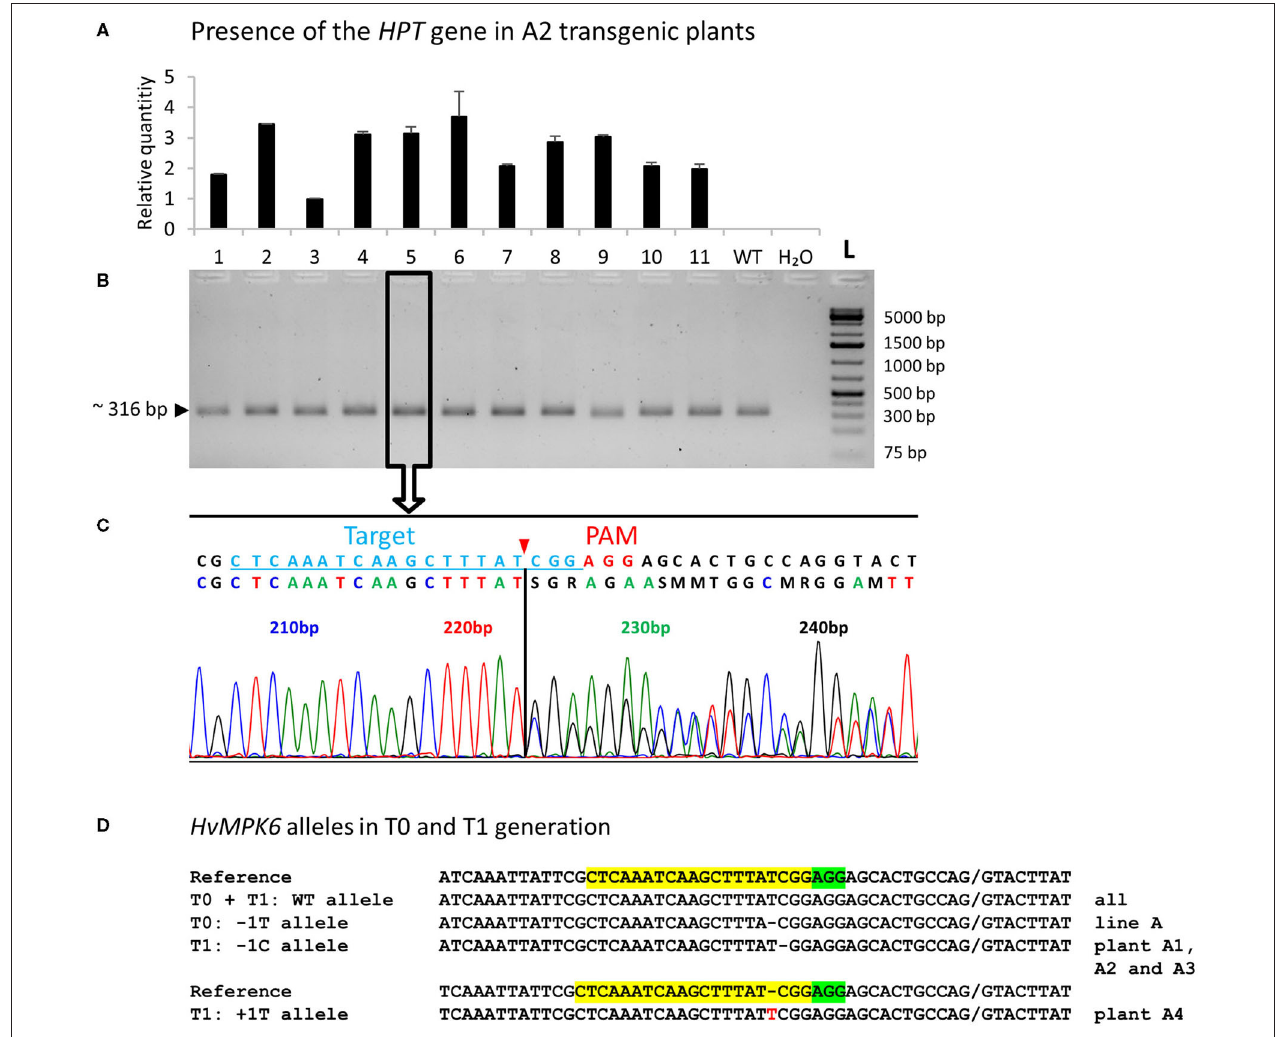
FIGURE 2 | Genotyping of the transgenic barley plants by multiplex TaqMan qPCR and on-target region sequencing—representative results and decoding of the HvMPK6 alleles of T0 and T1 plants. (A) Genotyping of T2-generation plants for the presence of the CC9-K6E3 construct. Genomic DNA was extracted from the leaves of 11 transgenic plants (numbered 1–11) and 1 wild-type (WT) plant and analyzed for the presence of the HPT gene by multiplex TaqMan qPCR with primers/probe sets for the HPT gene and barley reference CO2 gene ( Supplementary Table 1 ). Using the 2 − 11 Ct method ( Livak and Schmittgen, 2001), the amount of the HPT gene was normalized to the amount of the CO2 gene and is shown for each sample as relative to the sample from plant 3. All the analyzed transgenic plants contained a HPT gene whereas WT plant and a negative water-template control (H 2 0) did not. (B) The same plants were genotyped for the gRNA:Cas9-induced on-target mutations by PCR sequencing (PCR-Seq). The DNA fragment covering the on-target region was amplified from the genomic DNA of the analyzed plants by using PCR with primers K6E3_F1/K6E3_R1 ( Supplementary Table 1 ). About 316-bp PCR amplicon was associated with all analyzed plants including WT plant but not with a negative water-template control (H 2 O) L- O’GeneRuler 1kb Plus DNA Ladder (Thermo Fisher Scientific, Waltham, MA, USA). The expected size of the non-mutated PCR product is shown on the left, and the sizes of the selected ladder fragments are shown on the right. All about 316-bp PCR amplicons were sequenced. Open rectangle with an arrow indicates about 316-bp PCR amplicon associated with the plant 5 for which sequencing results are shown below. (C) Two overlapping sequencing chromatograms of similar signal intensity indicate heterozygous (monoallelic) or biallelic mutation in the HvMPK6 gene. Above the chromatograms, a deduced color-coded nucleotide sequence and reference WT nucleotide sequence including the position of the on-target site (underlined light blue typing) and the PAM site (red typing) are shown. The nucleotide numbering is shown as the distance in base pairs (bp) from the first nucleotide of the K6E3_F1 primer site. The deduced sequence corresponds to the WT sequence up to the third nucleotide position upstream of the PAM site (indicated by a vertical solid line) at which peaks start to overlap. Cas9 endonuclease from Streptococcus pyogenes cleaves target DNA sequences most frequently after the third nucleotide upstream of a PAM site (Jinek et al., 2012; Ran et al., 2015) (red arrowhead). The vertical solid line and red arrowhead point to the same position suggesting that the on-target was cleaved at the expected site and that the mutation/mutations occurred next to the cleavage site in the downstream direction relative to the PAM site. (D) HvMPK6 alleles of the mutated T0 and T1 transgenic plants. Superimposed sequencing chromatograms were decoded into allelic sequences by using the DSDecodeM tool (Liu et al., 2015b). The selected region of the WT HvMPK6 allele (plus strand) is shown as a reference on the top of each multiple sequence alignment with the gRNA on-target and PAM site highlighted in yellow and green, respectively. Slash indicates an exon/intron boundary and dash indicates single-nucleotide deletion. An inserted nucleotide is typed in red. The designation of an allele and respective transgenic generation is shown on the left and the designation of the line/plant is shown on the right of each sequence. Minus indicates deletion, plus indicates insertion, and bp indicates base pair.